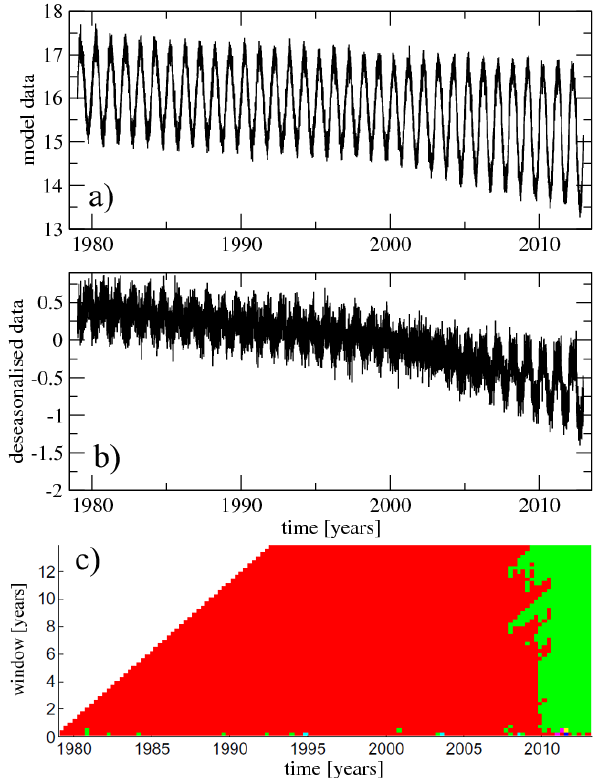
Fig. 4. Model “daily” data with an overall decline and increase in the amplitude of the lower half of the sine wave “seasonal cycle” as described in the text: (a) raw data, (b) deseasonalised data and (c) contour plot of the number of detected states in the deseason- alised